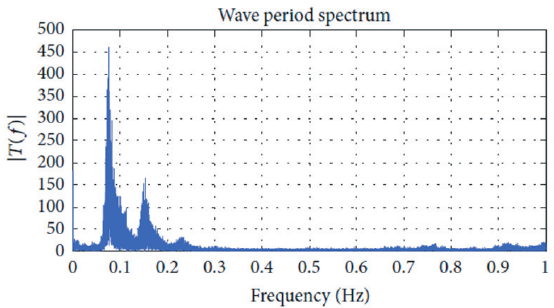
Figure 13. Representative spectral analysis of the waves at the site Mutriku on 12 May 2014 [27].